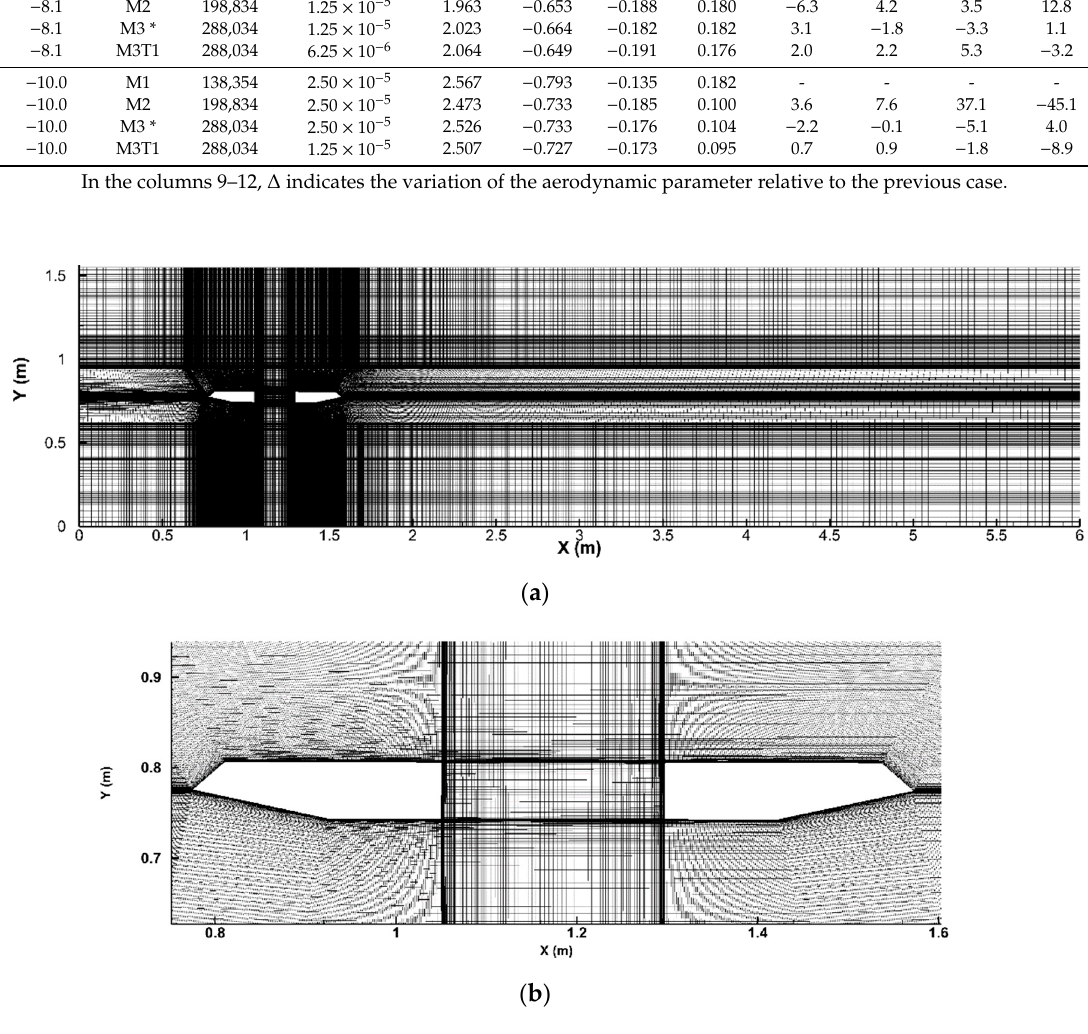
Table 2. Aerodynamic parameters for different grid and time resolutions for AoA <